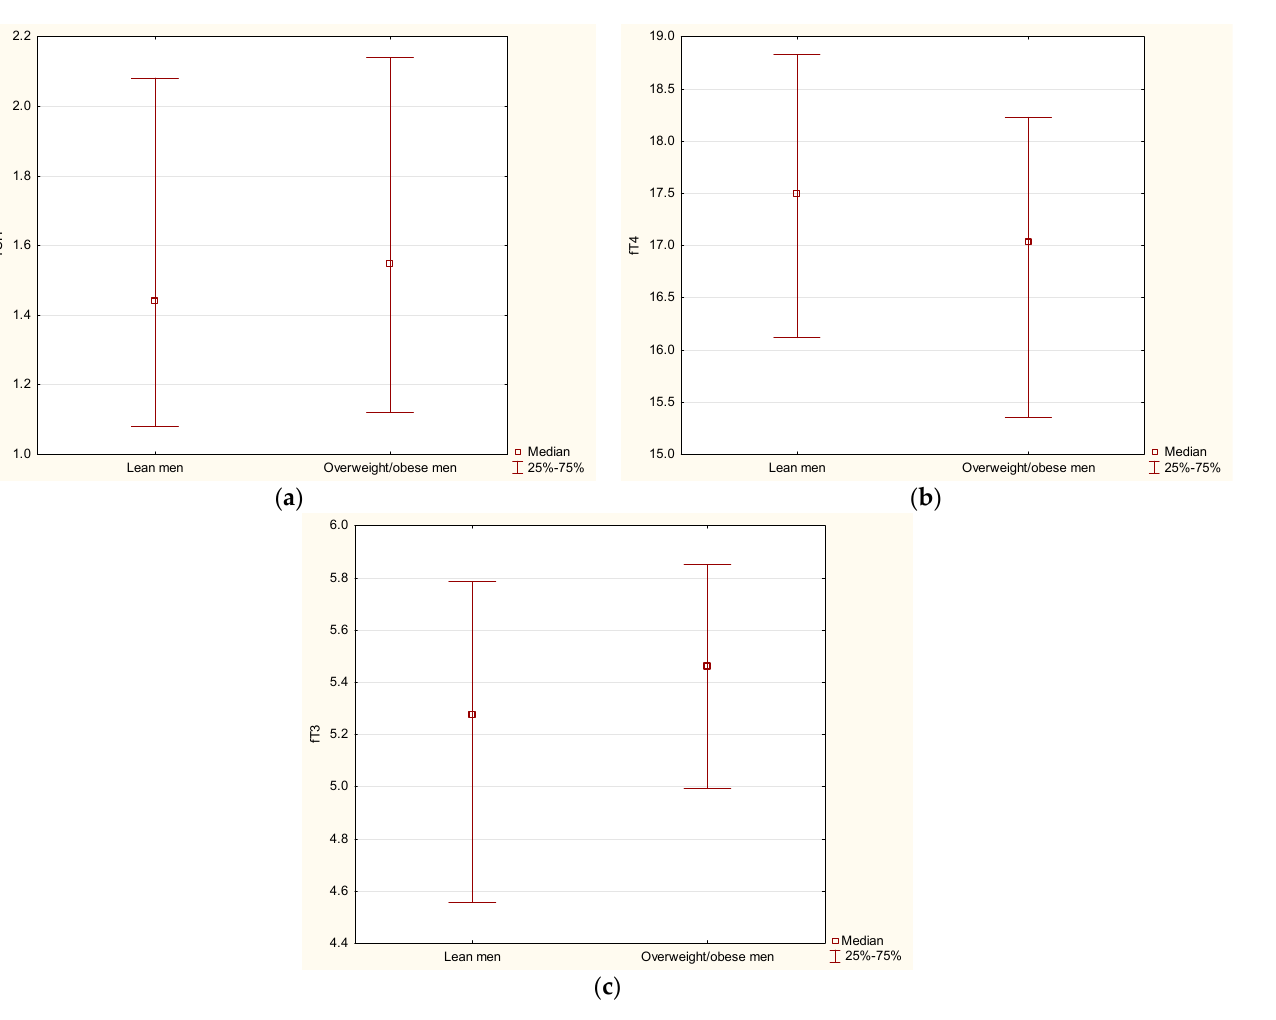
Figure 2. Serum levels of TSH ( a ), fT4 ( b ), and fT3 ( c ) in lean ( n = 84) vs. overweight/obese men ( n = 175).